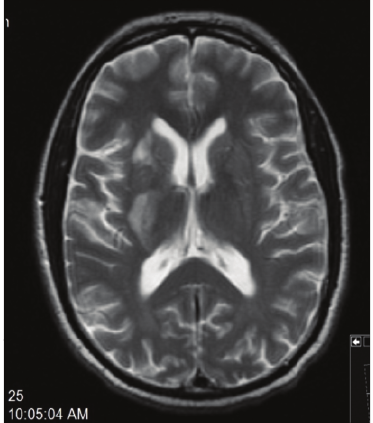
Figure 2: Brain MRI with gadolinium shows the infarct